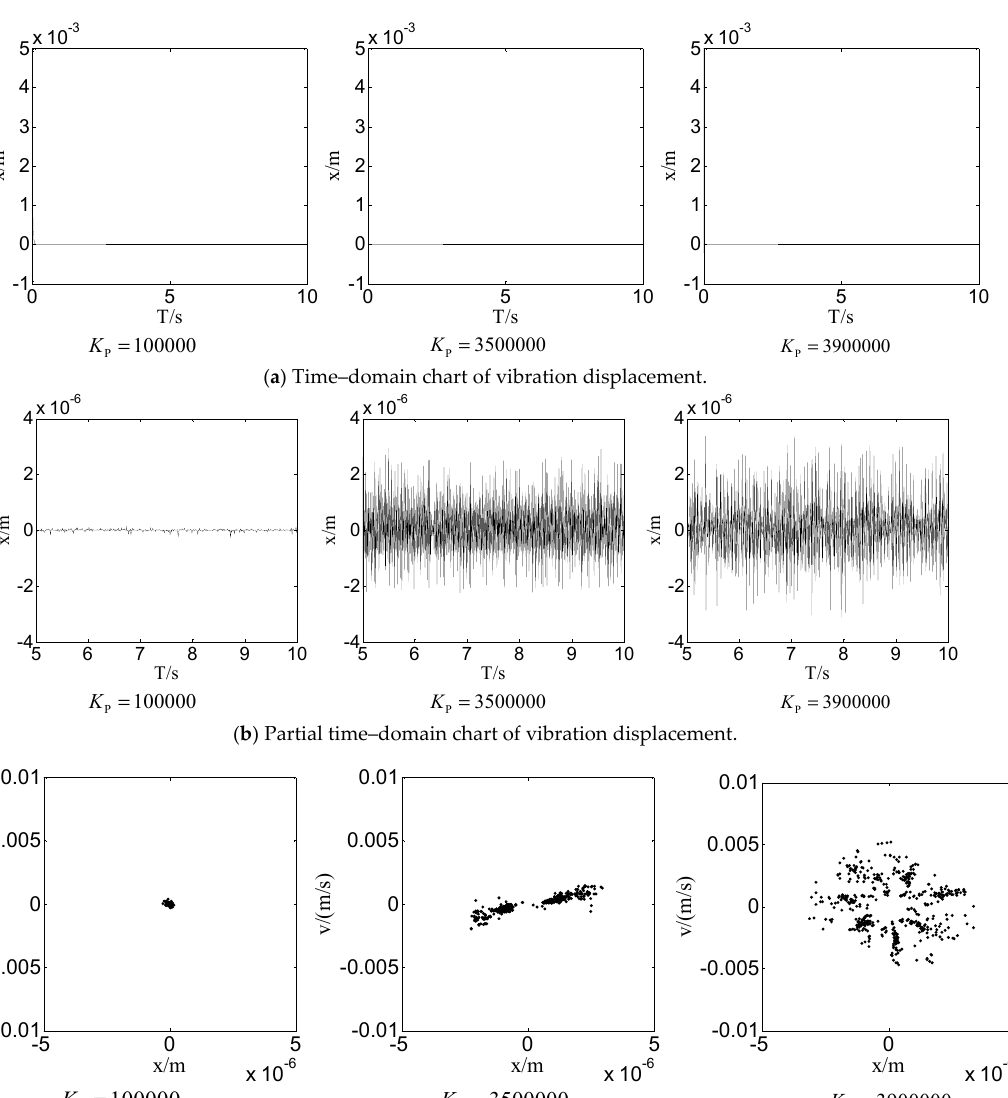
From the variation of vibration intensity in Figure 7, it can be found that the vibration intensity